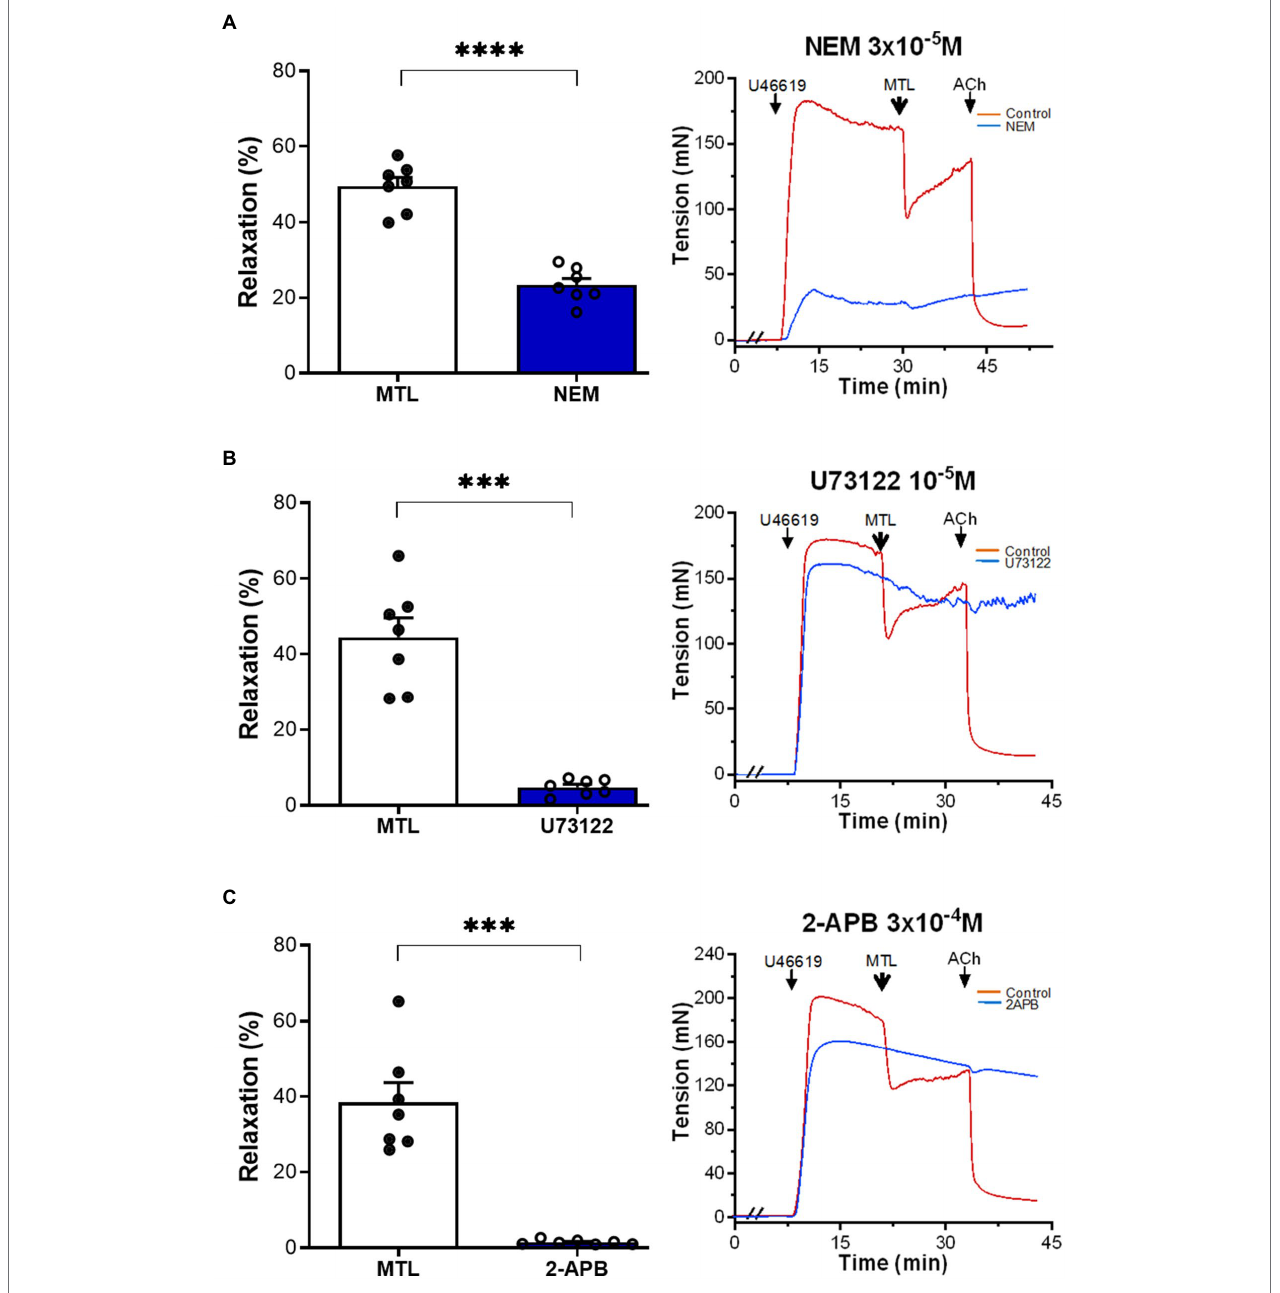
FIGURE 3 | Role of the G protein-PLC-IP 3 pathway on motilin-induced vasorelaxation. (A–C) Effect of NEM (3 × 10 − 5 M), U73122 (10 − 5 M), and 2-APB (3 × 10 − 4 M) on LGA relaxation induced by motilin (9 × 10 − 8 M) and corresponding representative traces. Values are means ± SEM ( n = 7). *** p < 0.001; **** p < 0.0001 by paired t - test. The double slash (//) indicates pretreatment with NEM, U73122, or 2-APB before incubation with U46619. The arrows indicate the time of drug administration. 2-APB, 2-aminoethyl diphenylborinate